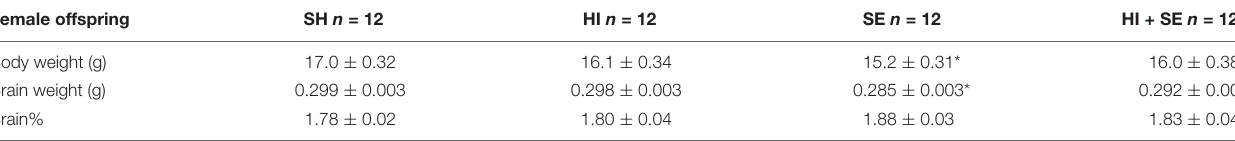
TABLE 1 | Anthropometric parameters of the female offspring at P45. Female offspring